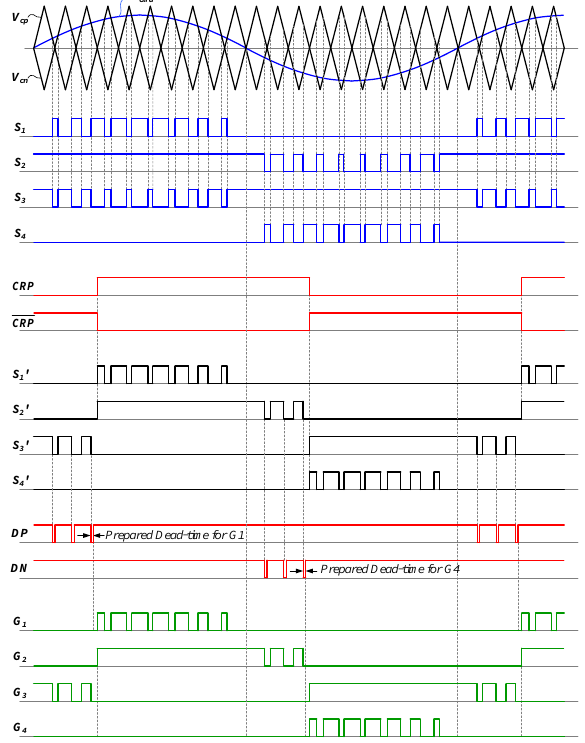
Figure 5. Proposed switching signal generation scheme.